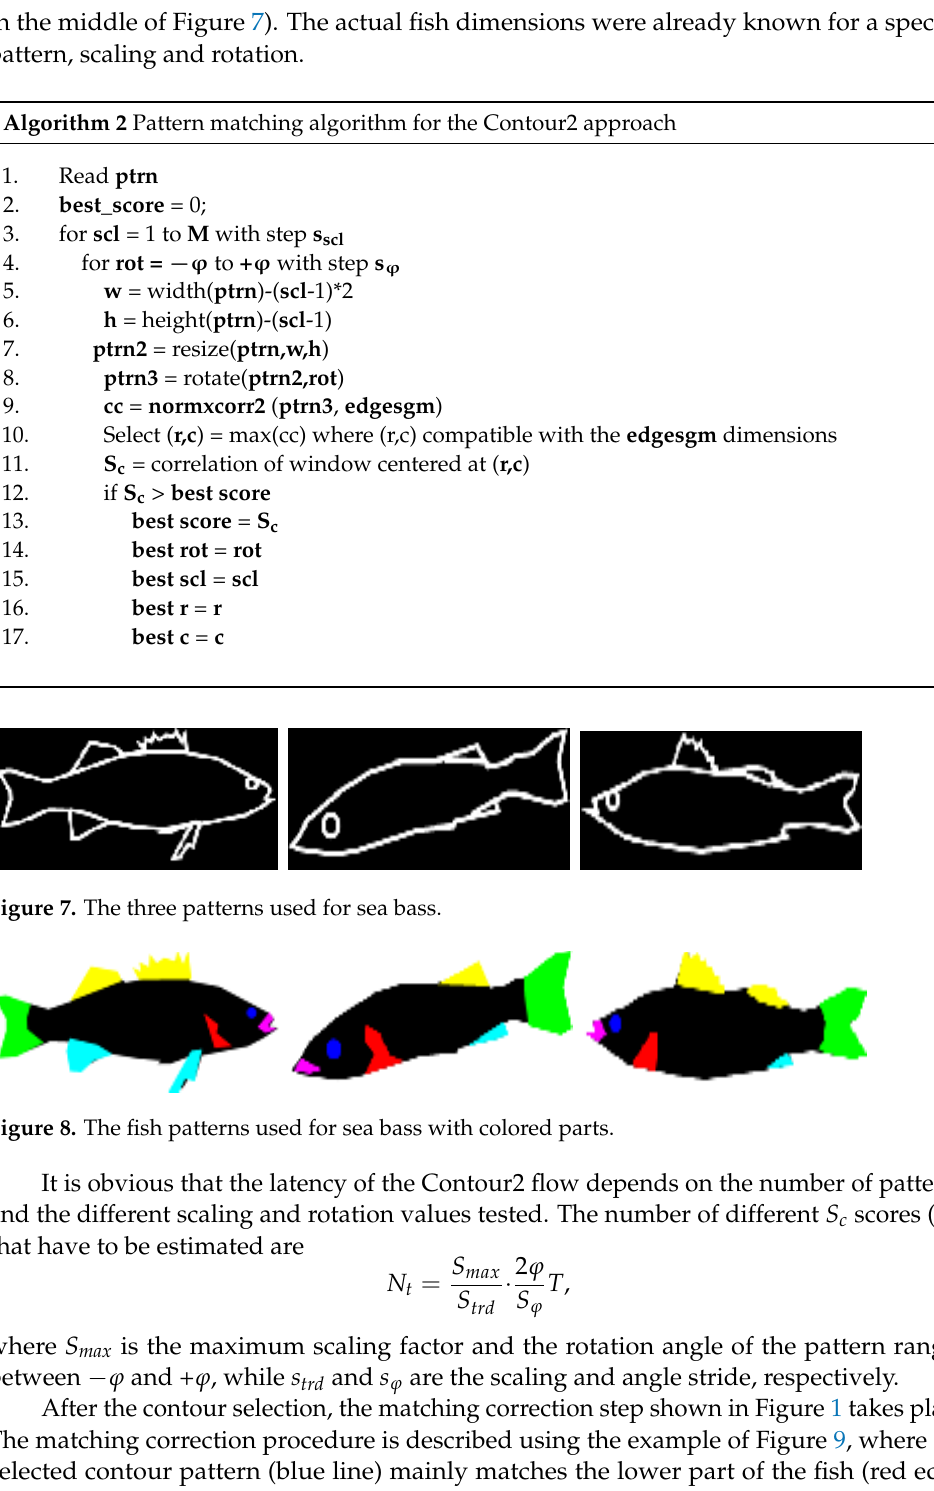
Algorithm 2 Pattern matching algorithm for the Contour2 approach